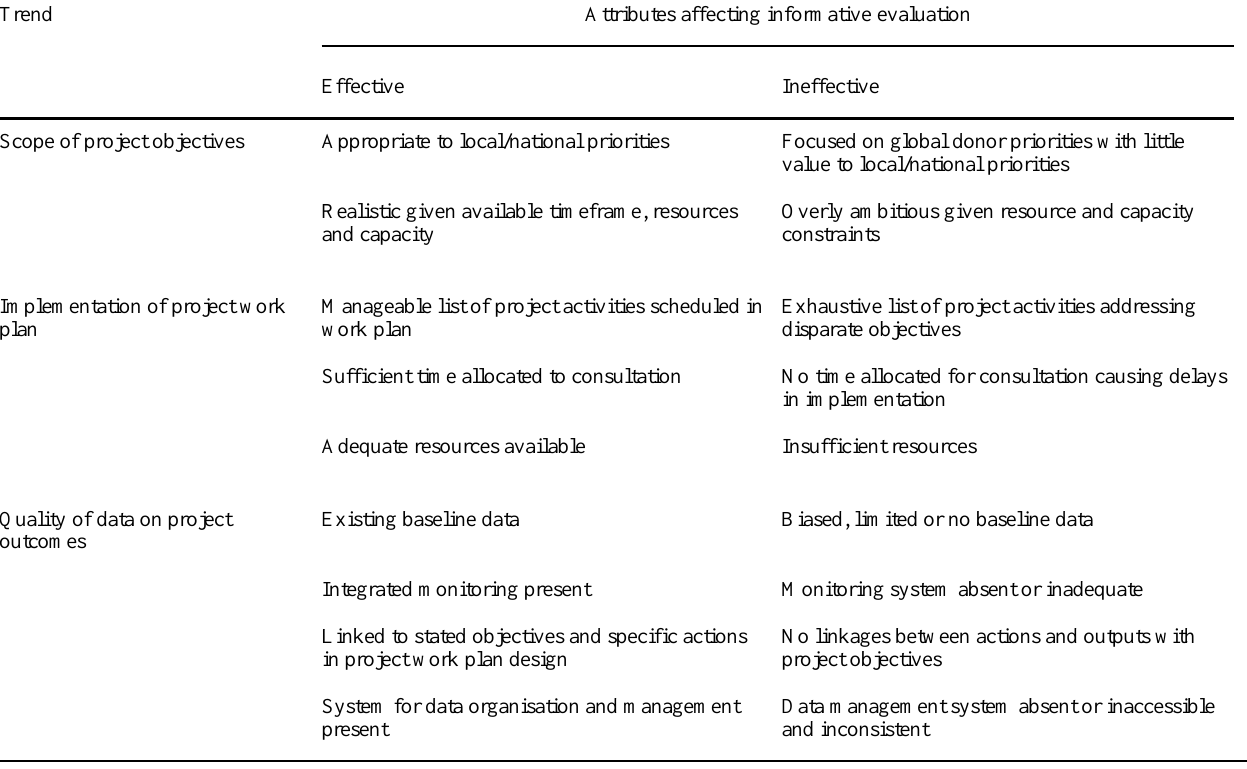
Table 2. Trends in management cycle related to project